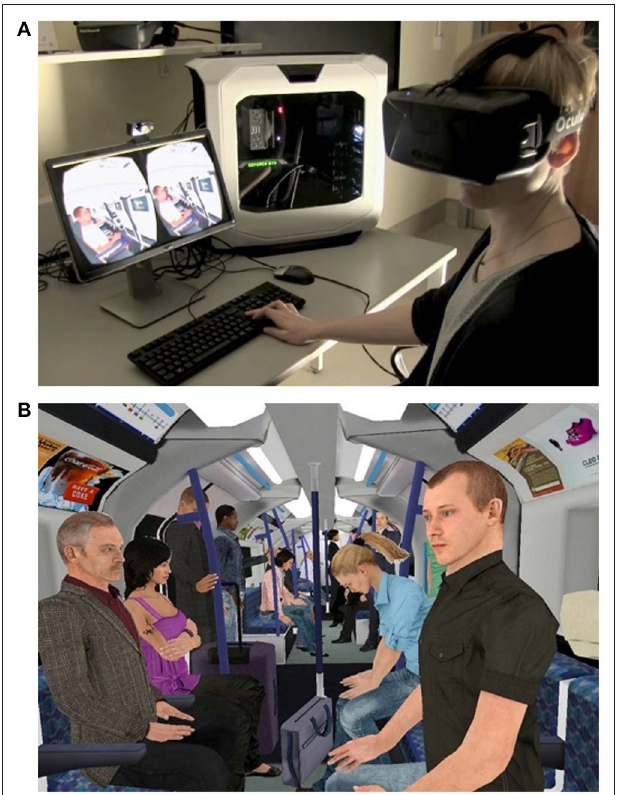
FIGURE 1 | (A,B) Screenshots from the video shown to participants, demonstrating a therapeutic VR program developed for the treatment of persecutory delusions (University of